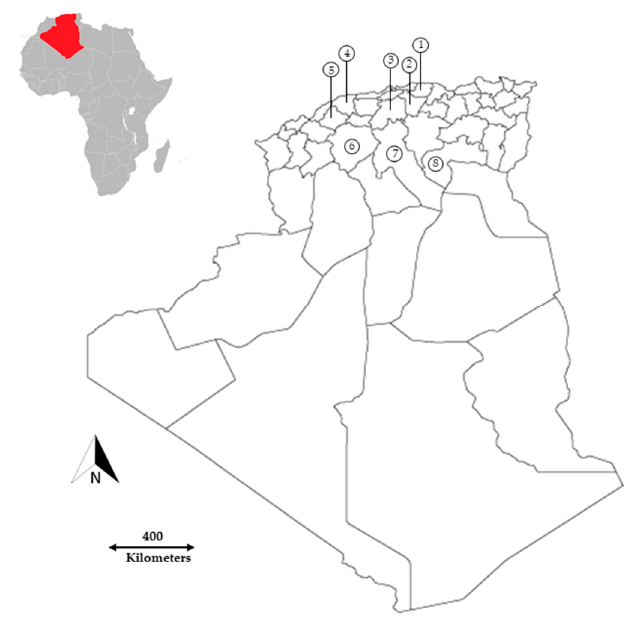
Figure 1. Map of Algeria emphasizing, in red color, the geographical positions of faba bean collection sites; 1, Tizi ouzou; 2, Bouira; 3, Medea; 4, Chlef; 5, Rhelizane; 6, Tiaret; 7, Djelfa; 8, Biskra.